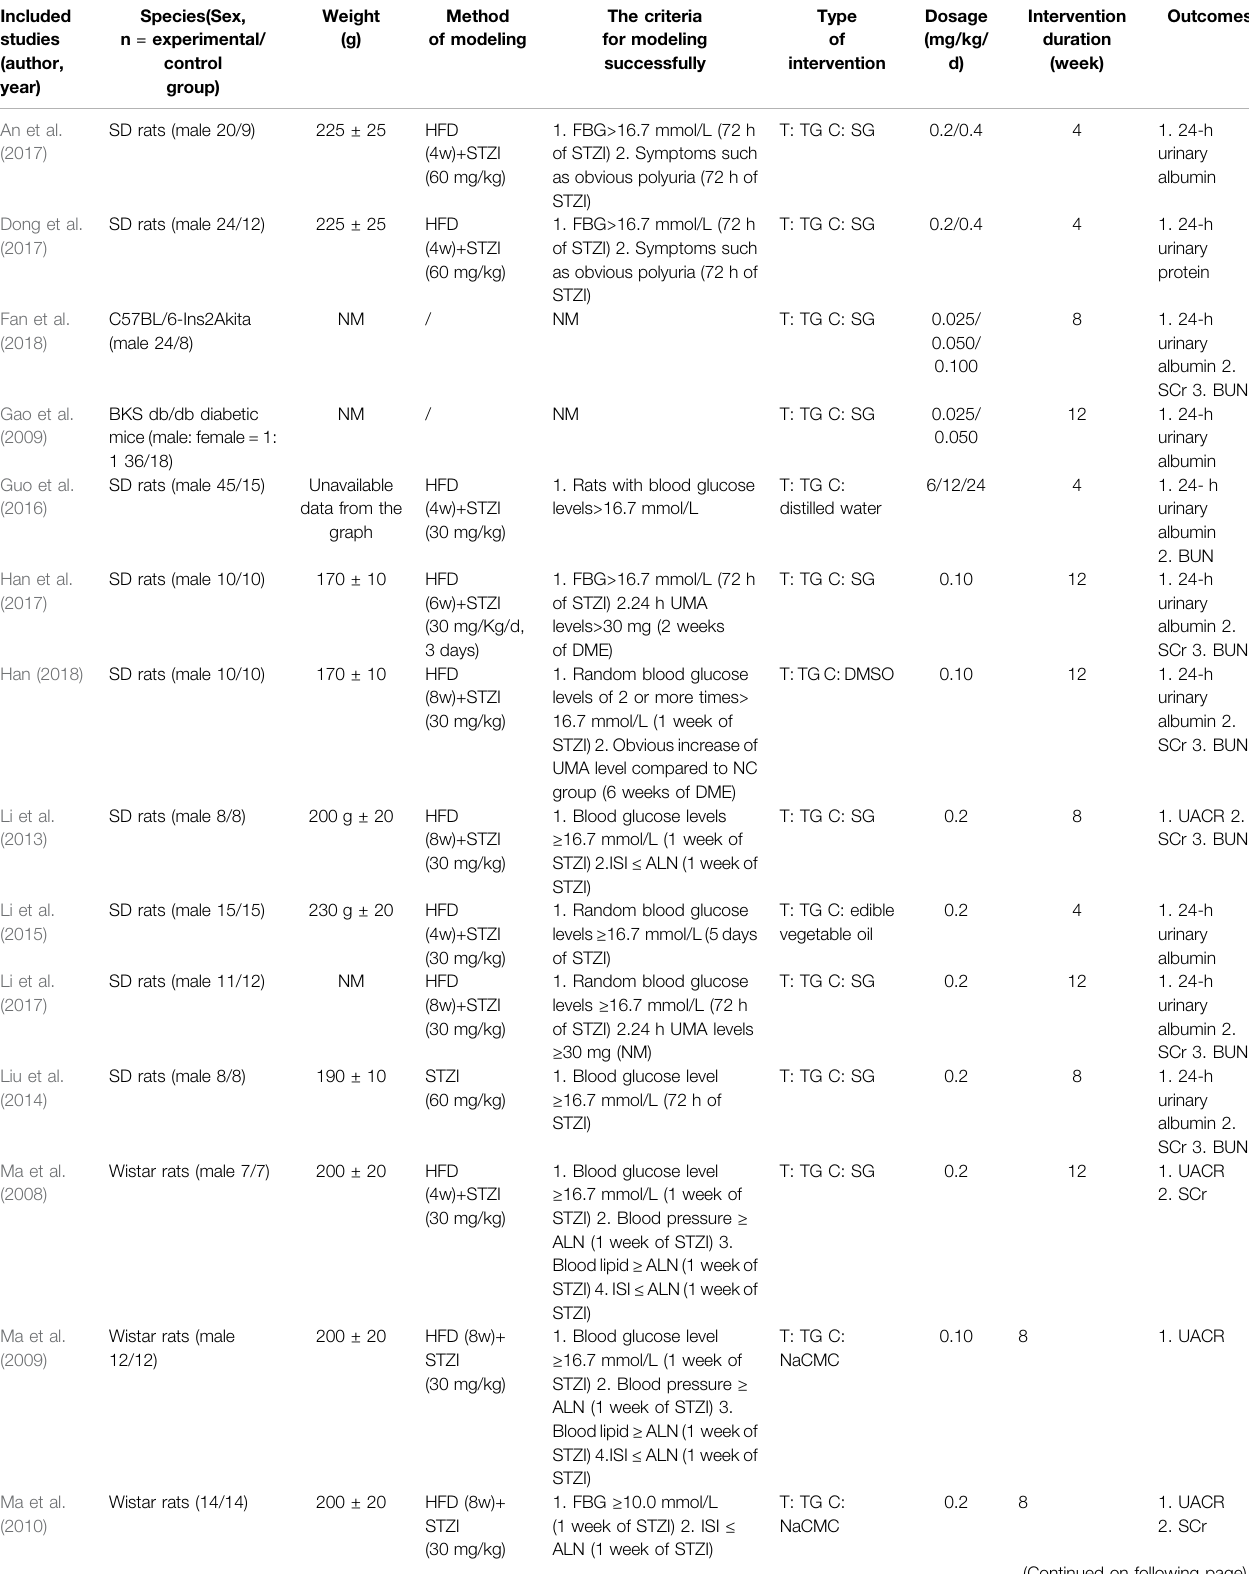
TABLE 1 | Characteristics of the studies included in the